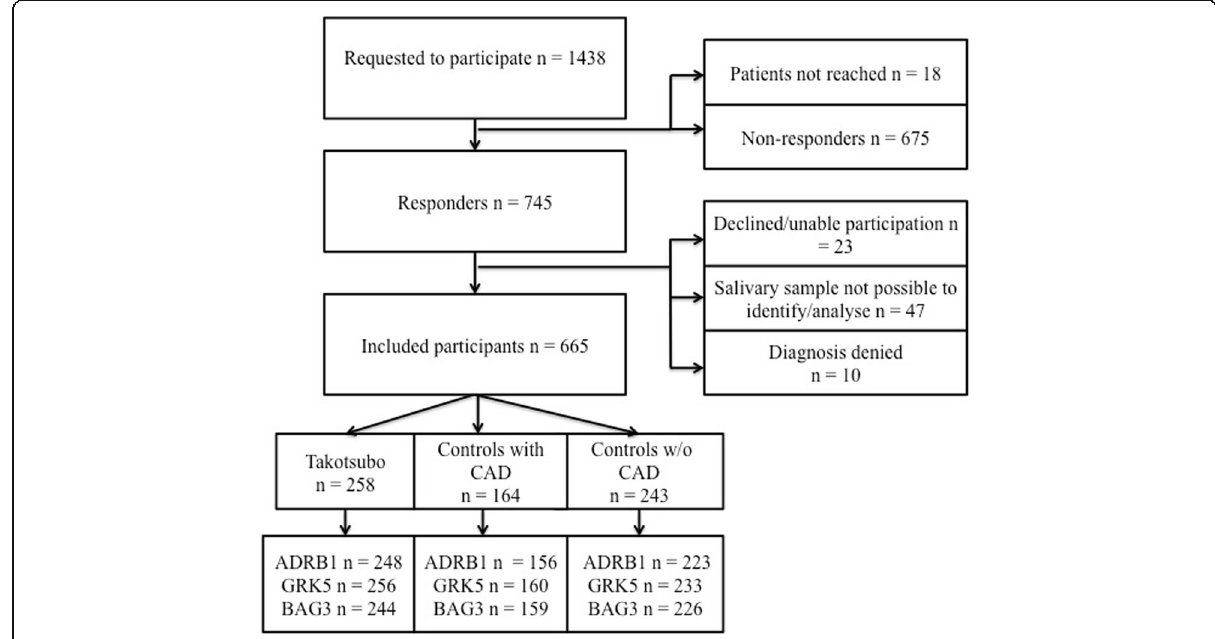
Fig. 1 CONSORT diagram. Participants were included if accepting to participate and donated a salivary sample useful for DNA analysis. ADRB1 = β 1-adrenergic receptor; BAG3 = Bcl-associated athanogene 3; GRK5 = G-protein-coupled receptor kinase